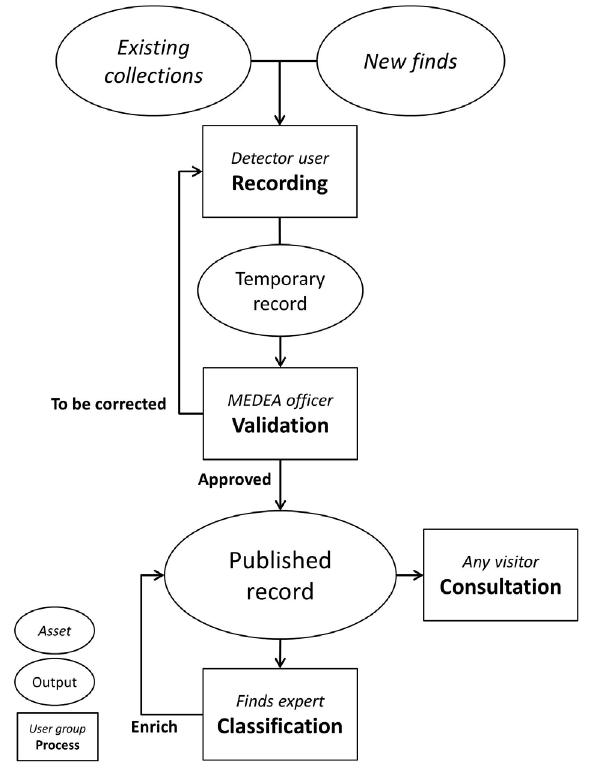
Figure 1. The basic workflow of the MEDEA platform, structured using the terminology of Dunn & Hedges